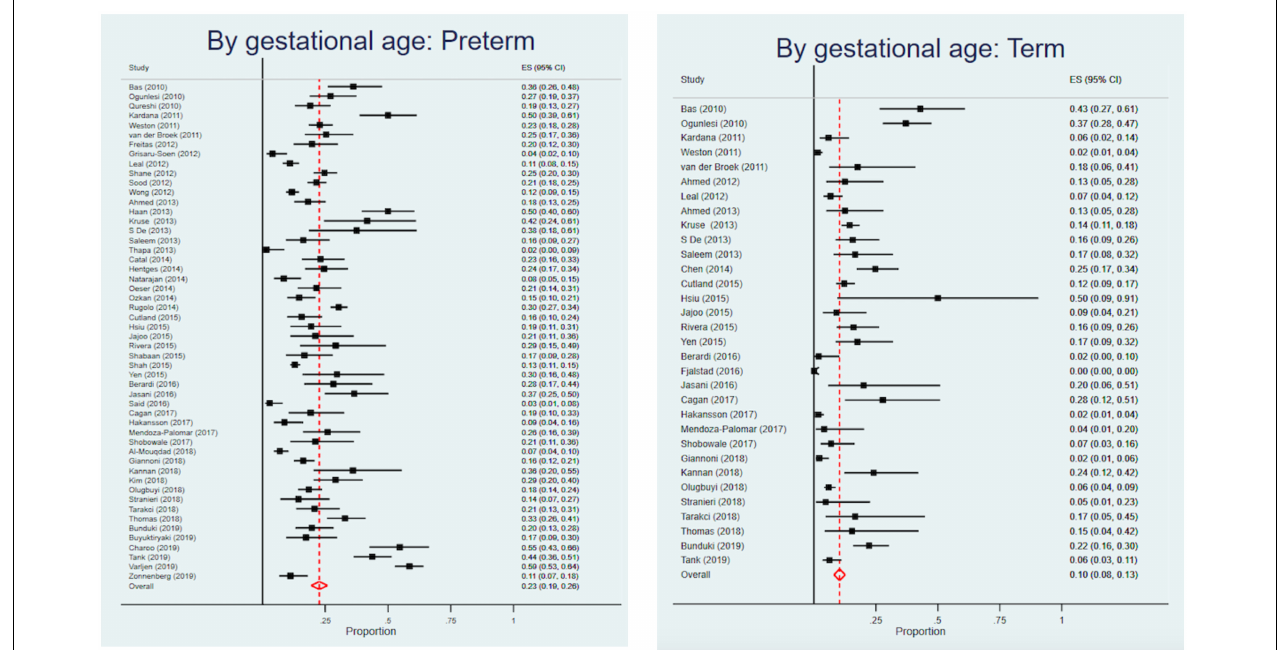
FIGURE 4 | Forest plots of preterm and term Case Fatality